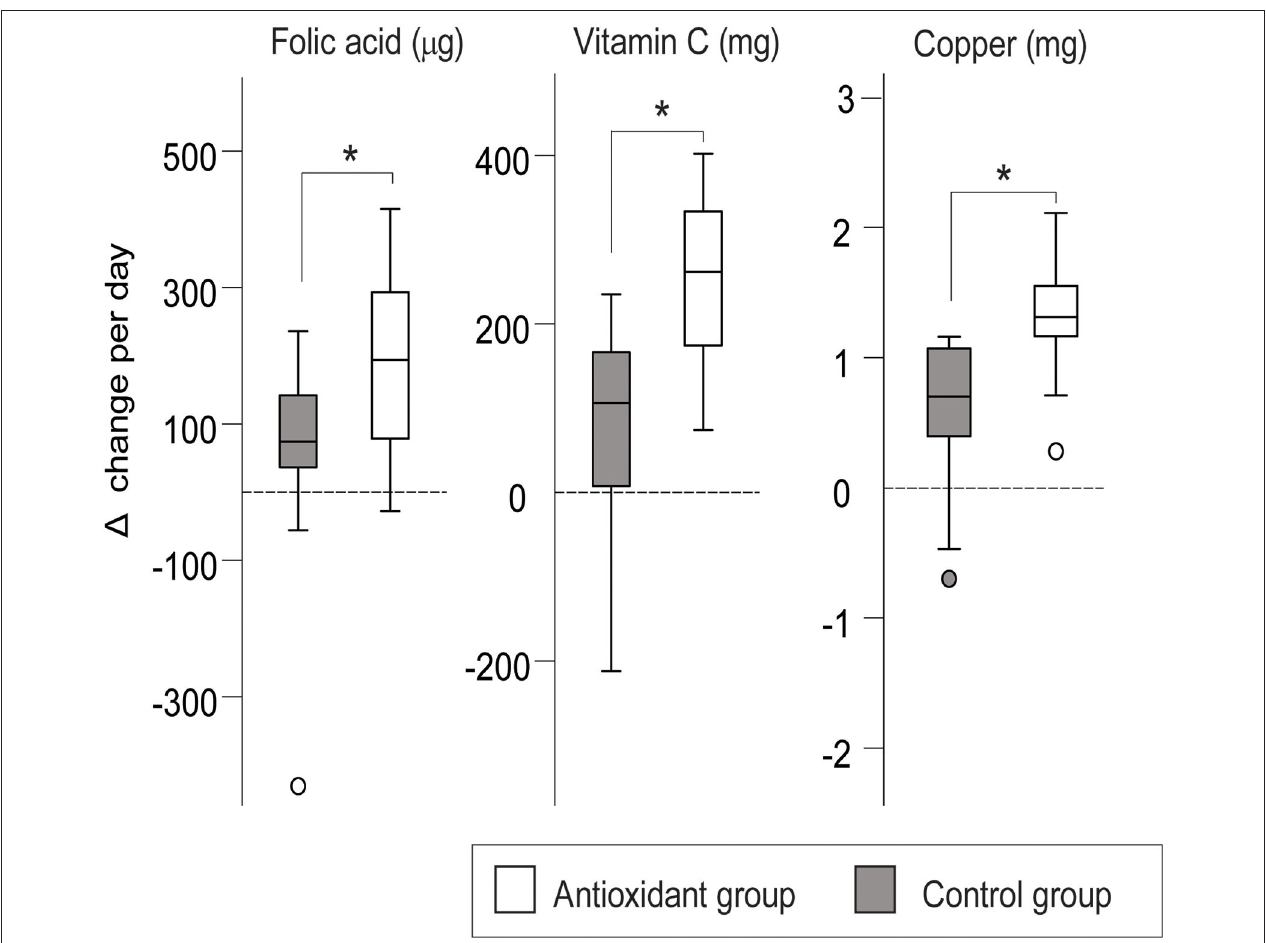
FIGURE 6 | Change in the mean daily intake of micronutrients (folic acid, copper, vitamin C) from Sea level to Altitude in the antioxidant and control group. Presented as mean Sea level—Altitude intra-individual change (%) and standard deviation. *indicates significant difference, p < 0.05. The p -value is obtained from comparing the change from Sea level to Altitude between the groups using t -test or MW tests depending on the normality of the